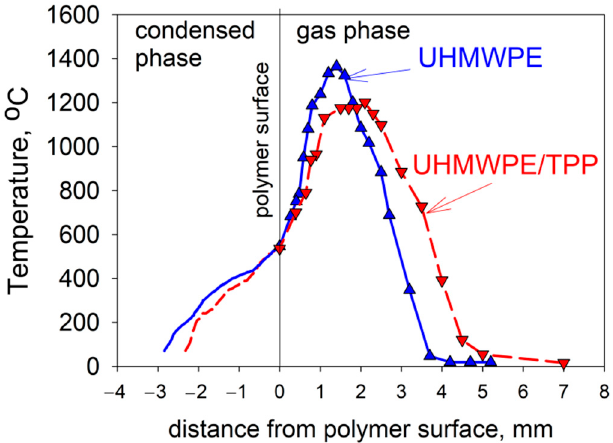
Figure 20. The temperature profiles in the condensed and gas phases in UHMWPE burning. Solid line—UHMWPE; dashed line—UHMWPE + 5 wt% of TPP.